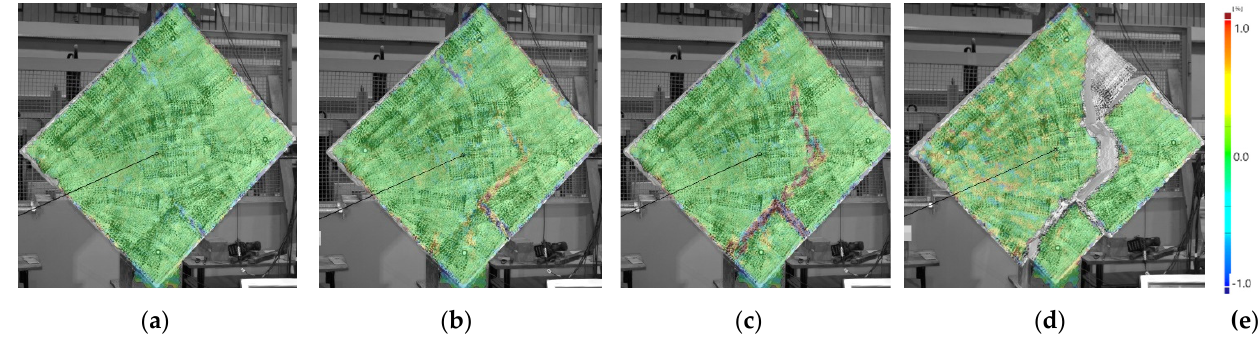
Figure 11. The process of strain growth in unstrengthened wall of Y-US series: ( a ) beginning of deformations in vertical joints; ( b ) loss of adhesion in bed joints; ( c ) deformation just before failure; ( d ) damage of wall; ( e ) deformation scale.